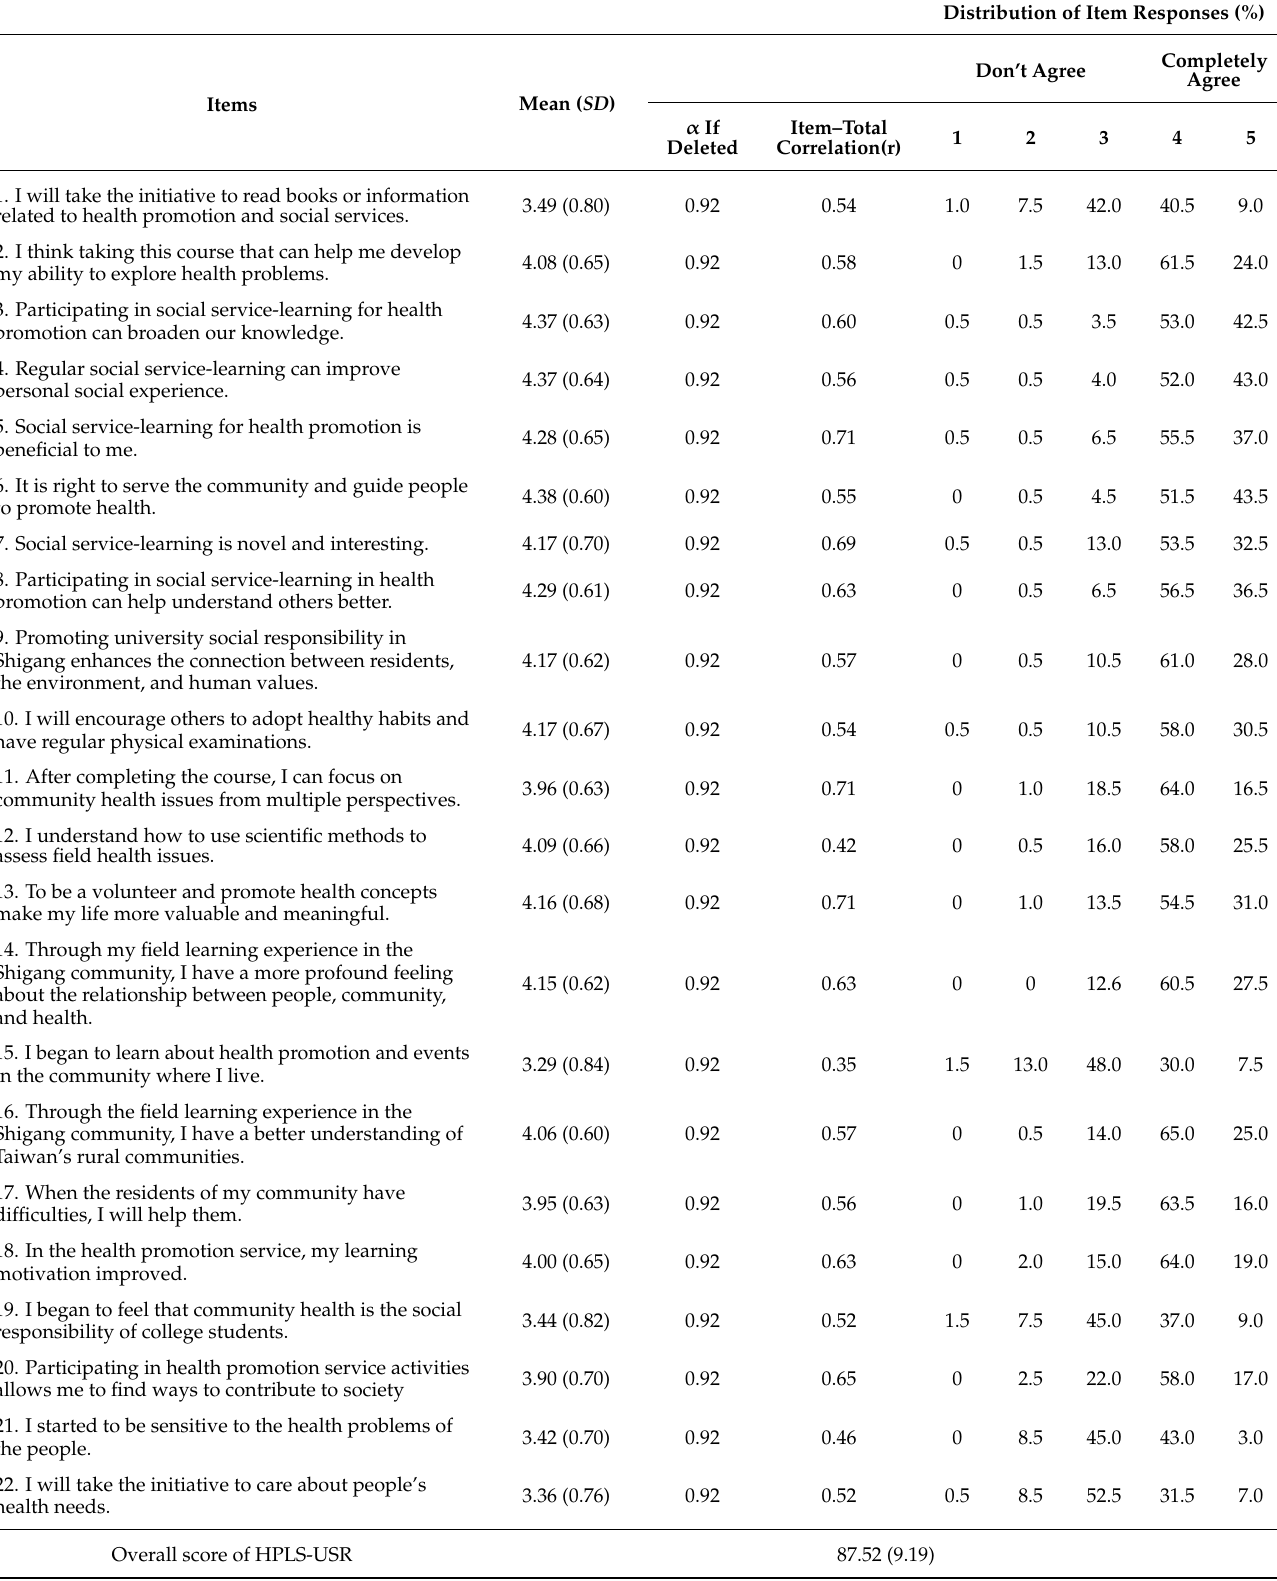
Table 2. Descriptive statistics and CTT results for the